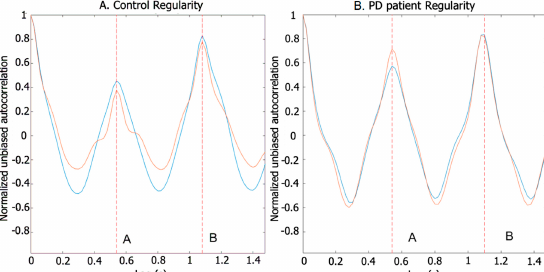
Figure 3. Regularity based on autocorrelation of accelerometer signals. ( A ) Control regularity. ( B ) Patient Regularity. (Red) left arm. (Blue) Right arm. The first peak (A) reveals the regularity of the step, whereas the second peak (B) reveals the regularity of the stride. Patient presents a lower A peak than control one. The B peaks in both cases are similar.